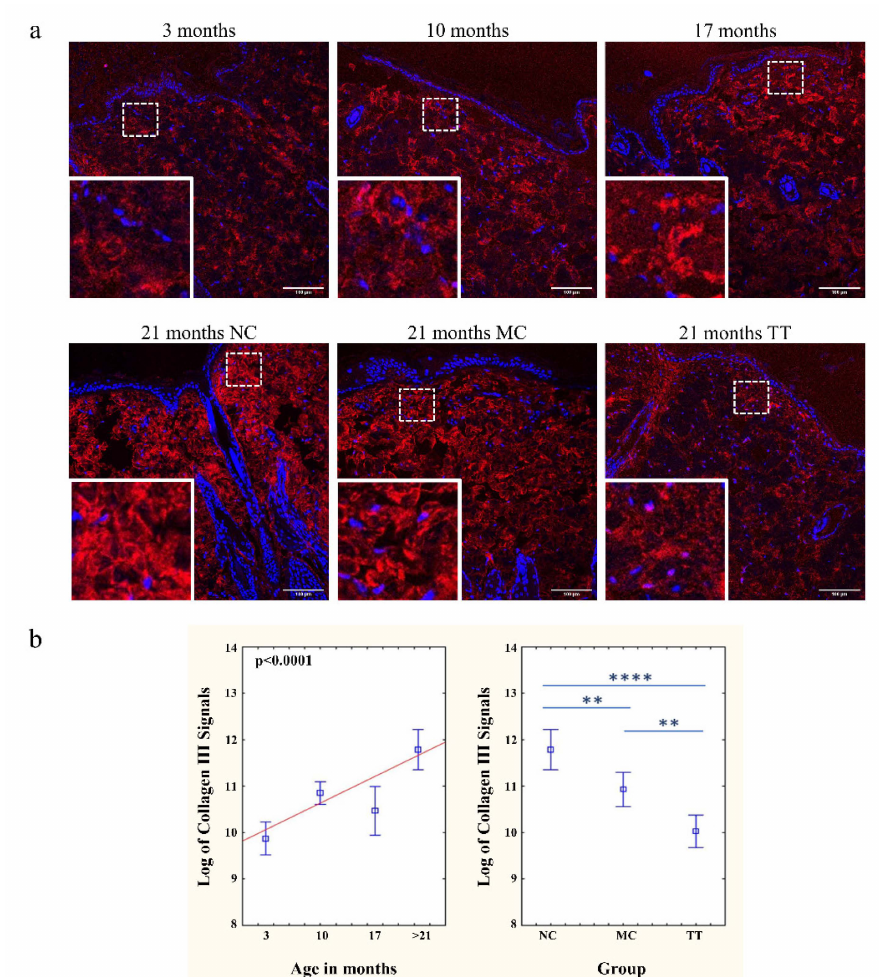
Figure 4. Implanted young fibroblasts change collagen III immunofluorescence pattern in aged skin. ( a ) Collagen III (red) in the untreated skin of rats of different ages (3, 10, 17 months) and in the untreated skin (NC), mechanically treated skin (MC), and skin treated with young cells (TT) of the same 21-month-old rat. The bottom left corner of each picture presents an enlarged selected area. Scale bar is 100 µ m. ( b ) Graphs represent CTCF for collagen III immunofluorescence signals in the skin of untreated rats (3, 10, 17, and >21 months, NC; left). Changes in collagen III signals of >21 months old animals following micro-transplantation procedure (NC, MC, TT; right). n = 3 per group; error bars represent mean ± 0.95 confidence intervals; ** p < 0.01; **** p <